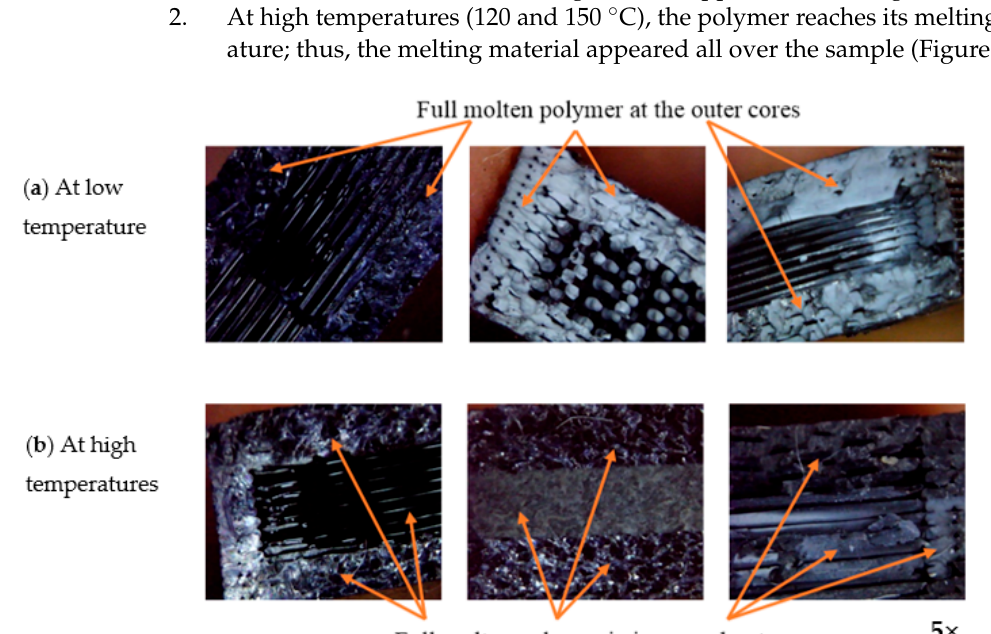
Figure 13. Effect of heat treatment on the surfaces of different samples, ( a ) At low temperature (50 °C), ( b )At high temperatures (120, 150 °C).